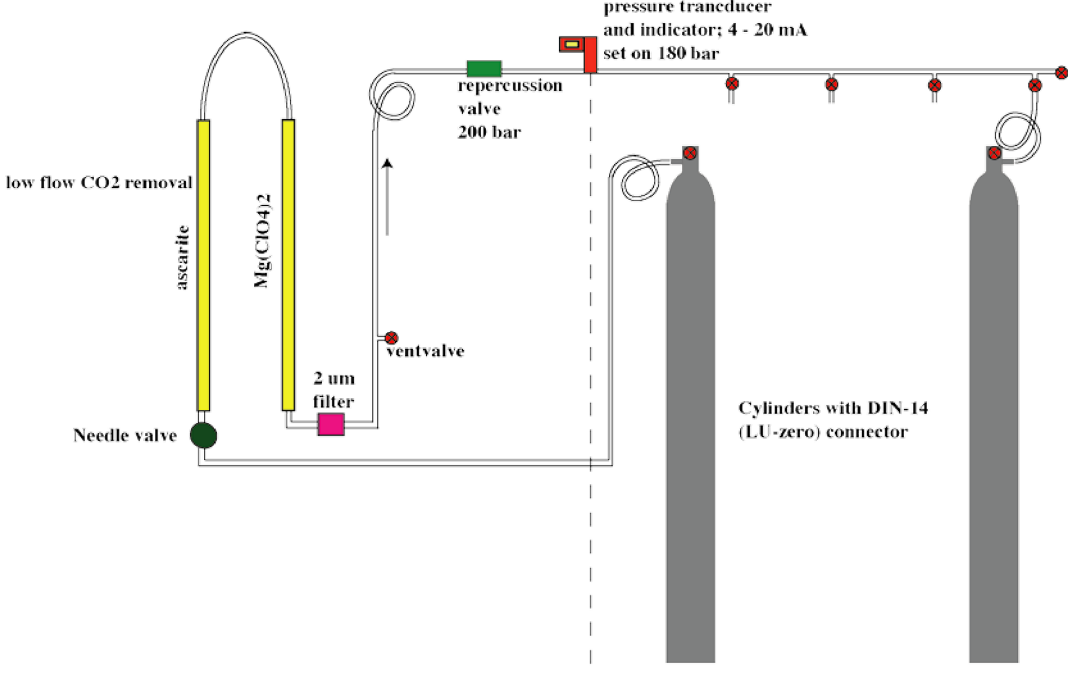
Figure D1. Setup for the preparation of the low reference. The cylinder on the left is the high reference, filled until ∼ 150 bar at start time of preparation. The right cylinder is empty at start time of